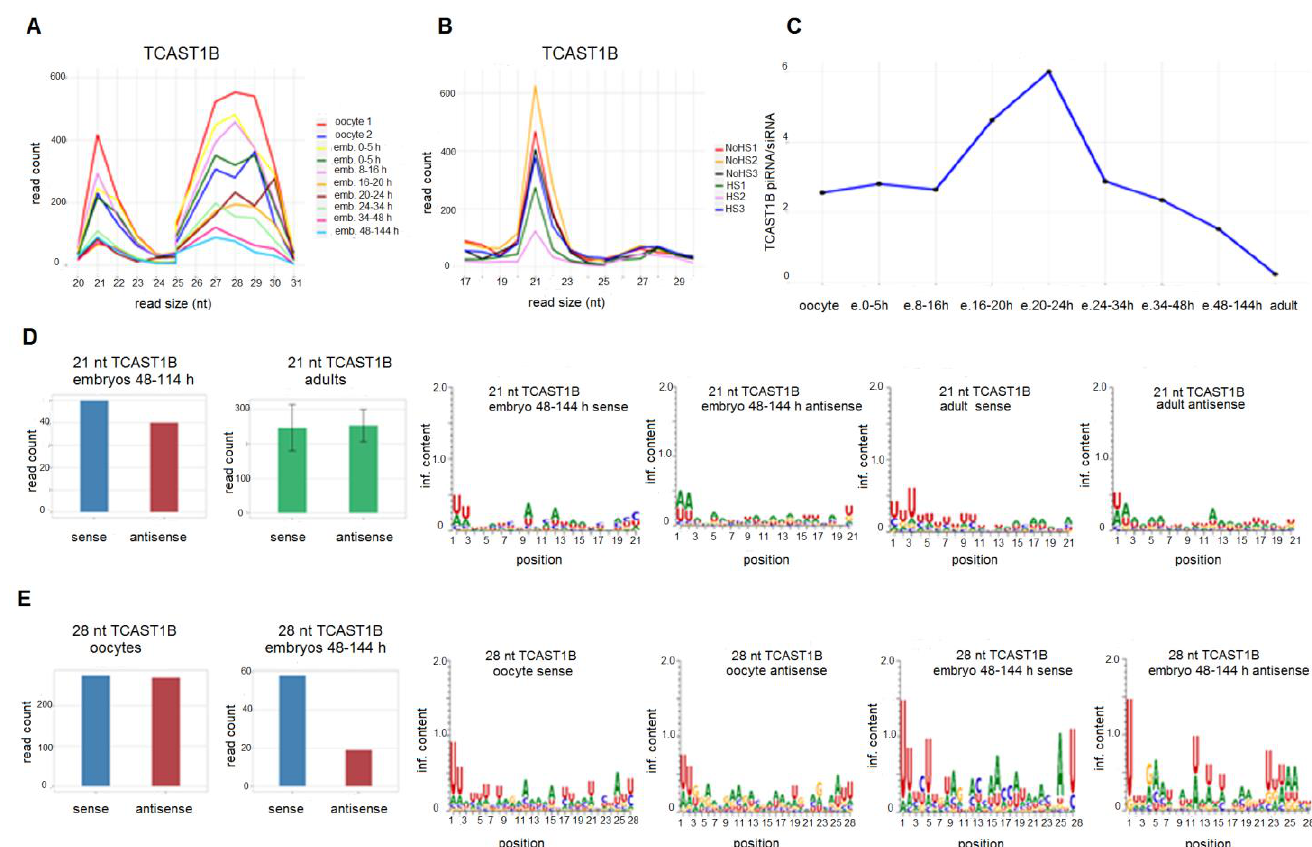
Figure 2. Size and count distribution of reads mapped to TCAST1B satellite in T. castaneum oocyte and embryonic small RNA libraries ( A ) and in small RNA libraries of adults kept at normal temperature (NHS), as well as adults subjected to heat stress (HS) ( B ). Ratio between TCAST1B piRNA (26–30 nt) and TCAST1B siRNA (21–22 nt) reads during development ( C ). Number of 21 nt reads mapped on the sense and antisense strand of TCAST1B in embryos (48–144 h) and adults as well as the sequence logos for sense and antisense 21 nt reads ( D ). Number of 28 nt reads mapped on sense and antisense strand of TCAST1B in oocytes and embryos (48–144 h), as well as the sequence logos for sense and antisense 28 nt reads ( E